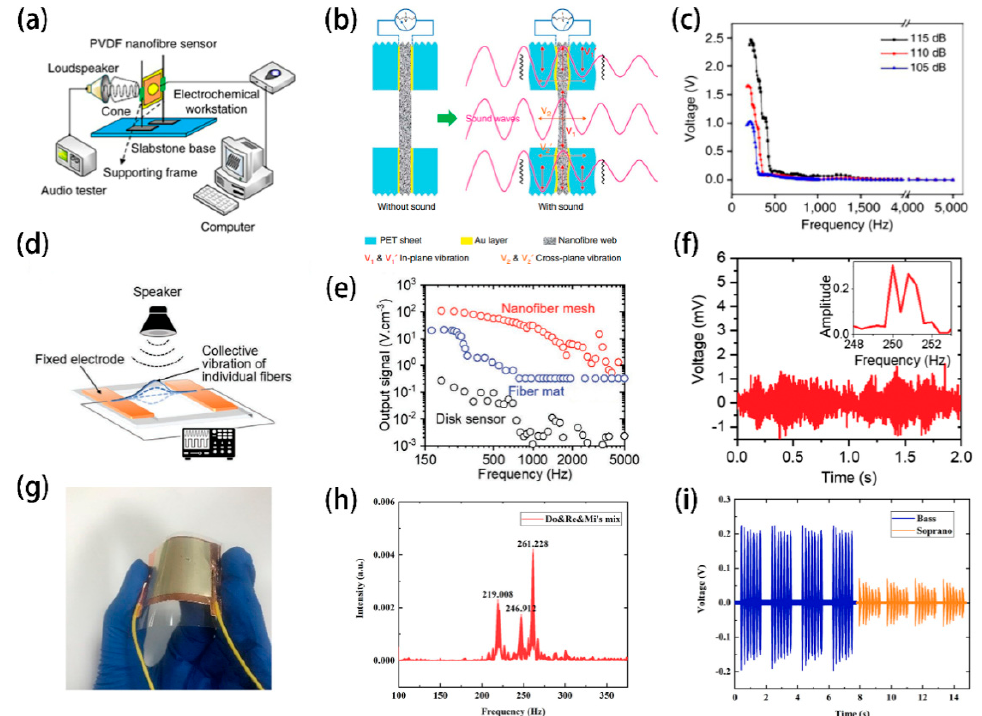
Figure 4. Schematic illustration of ( a ) the setup for testing the device, ( b ) proposed sound vibration modes and piezoelectric conversion mechanism for the nanofiber device. ( c ) The effect of sound wave frequency on output voltage. ( d ) Schematic illustration of the experimental setup. Reproduced from [118] with permission from the Springer Nature, copyright 2016. ( e ) Acoustic sensing bandwidth of the nanofiber mesh compared with the 40 µ m thick nanofiber mat and a commercial piezoelectric acoustic sensing dish. ( f ) Signal output of nanofiber mesh at two interfering frequencies (250, 251 Hz) at 70 dB, and the FFT processed spectrum. Reproduced from [123] with permission from the John Wiley and Sons, copyright 2020. ( g ) The photo of SDRS. ( h ) Frequency domain signal map as detected by the SDRS from a sound signal consisting of mixed Do, Re and Mi tones. ( i ) Voltage signal diagram of the bass and soprano sound collected by the device. Reproduced from [116] with permission from the Elsevier, copyright 2020.